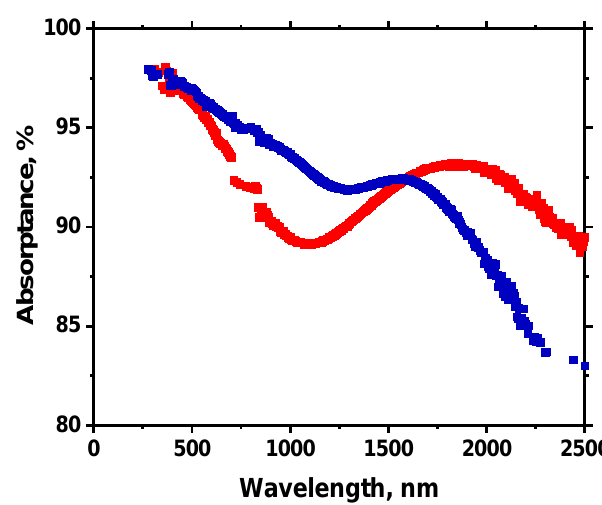
Figure 4. Absorptance spectra of CNT coatings without binders (red line) and with a binder / CNT ratio of 8.4:1 (blue line).